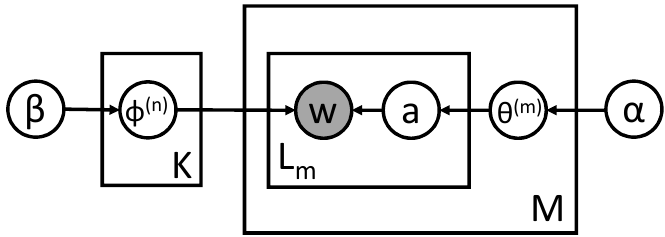
Figure 2. Graphical model for psychological feature modeling. Shaded and unshaded circles indicate observed and unobserved variables, respectively. Arrows refer to the dependences between variables. Boxes indicate repetitions of sampling